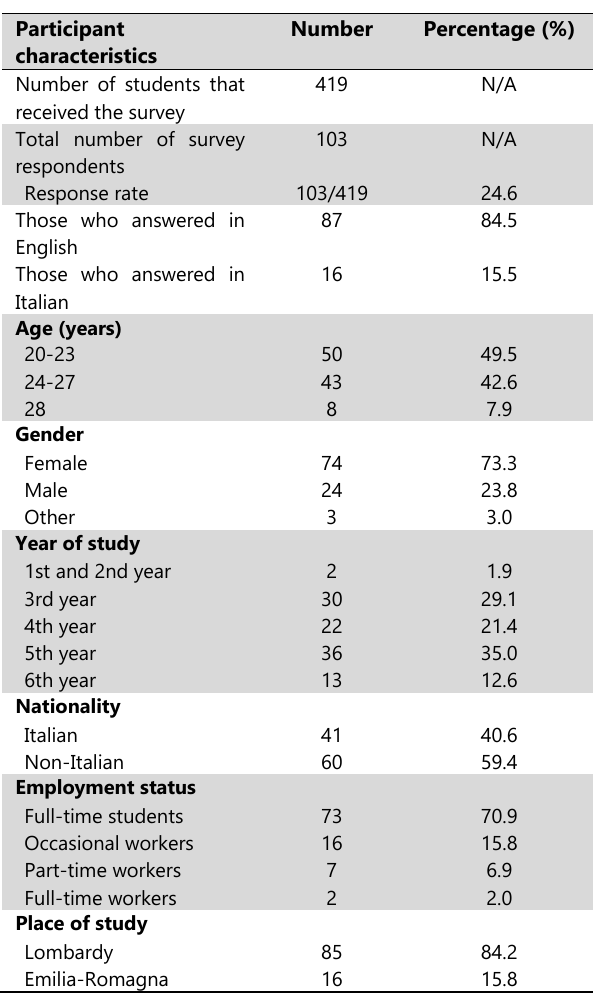
Table 1 . Participant’s